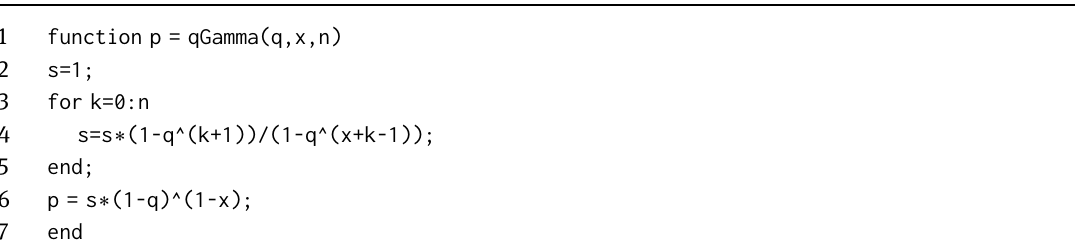
Algorithm 3. MATLAB lines for calculation of ( ) x Γ